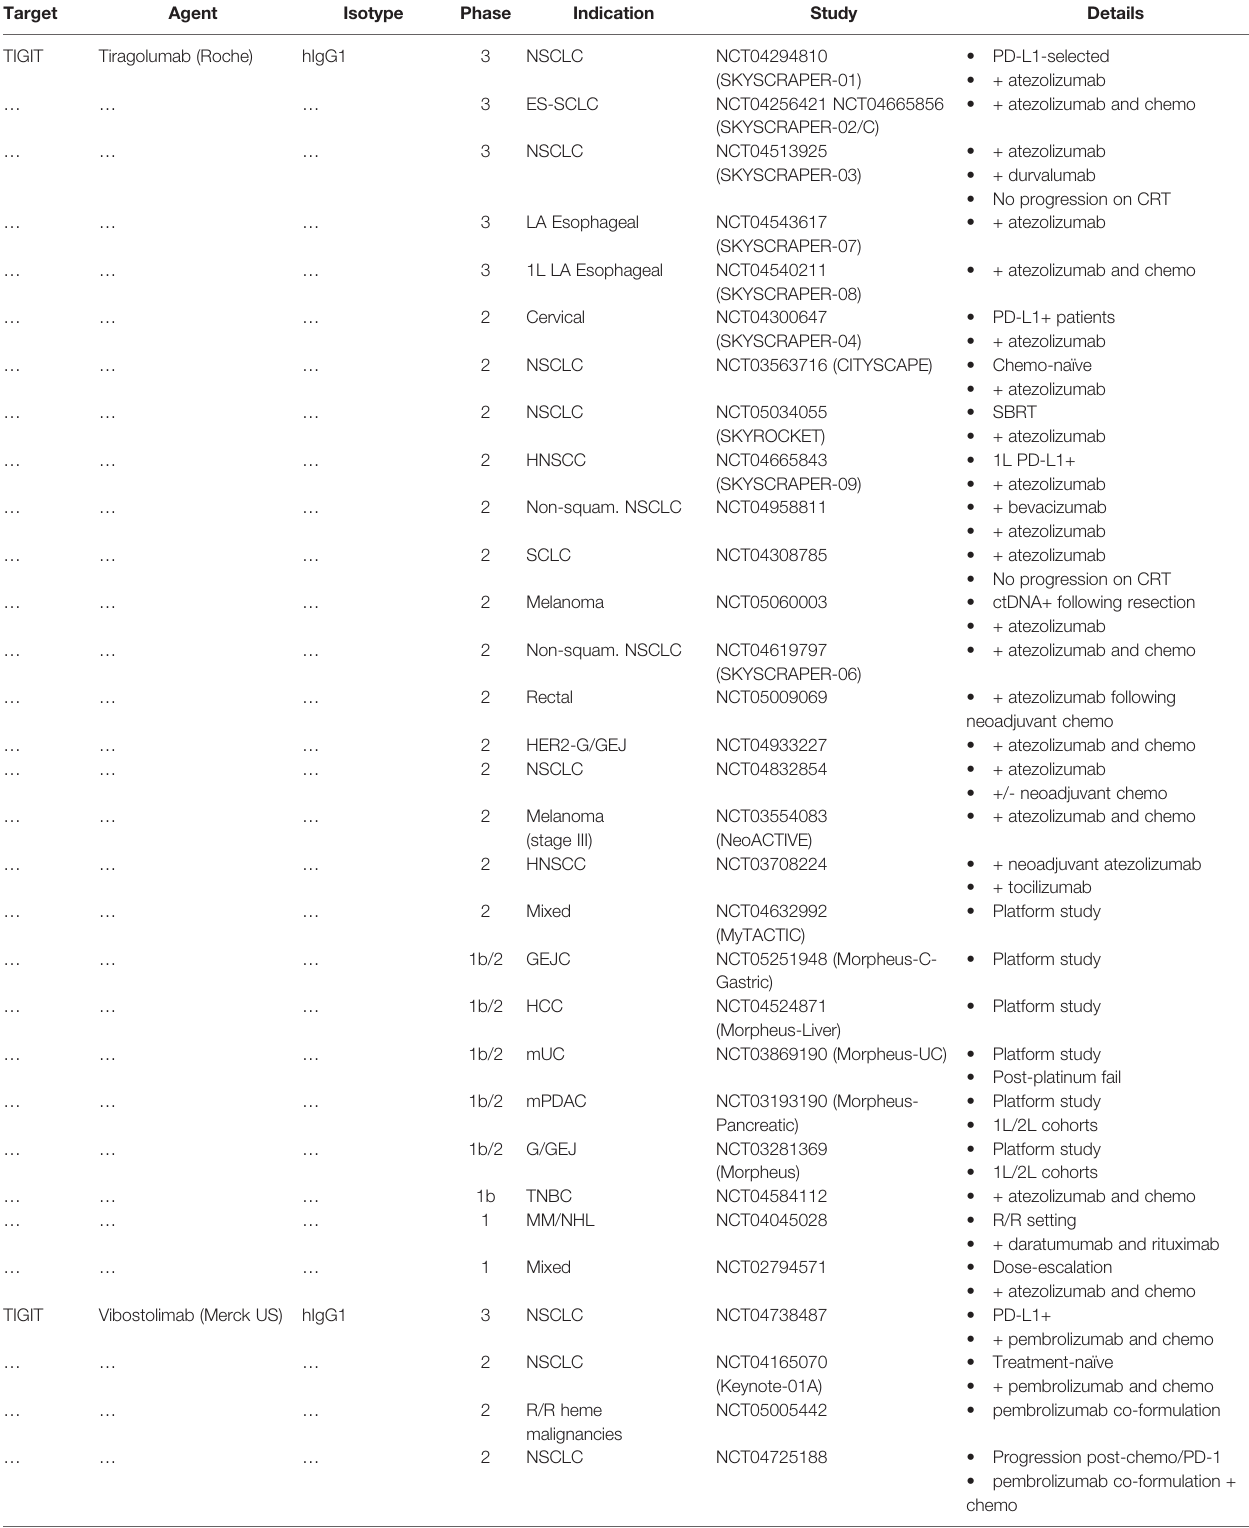
TABLE 3 | Ongoing or discontinued (terminated) clinical trials evaluating CD226 axis-related antibody-based therapies in cancer